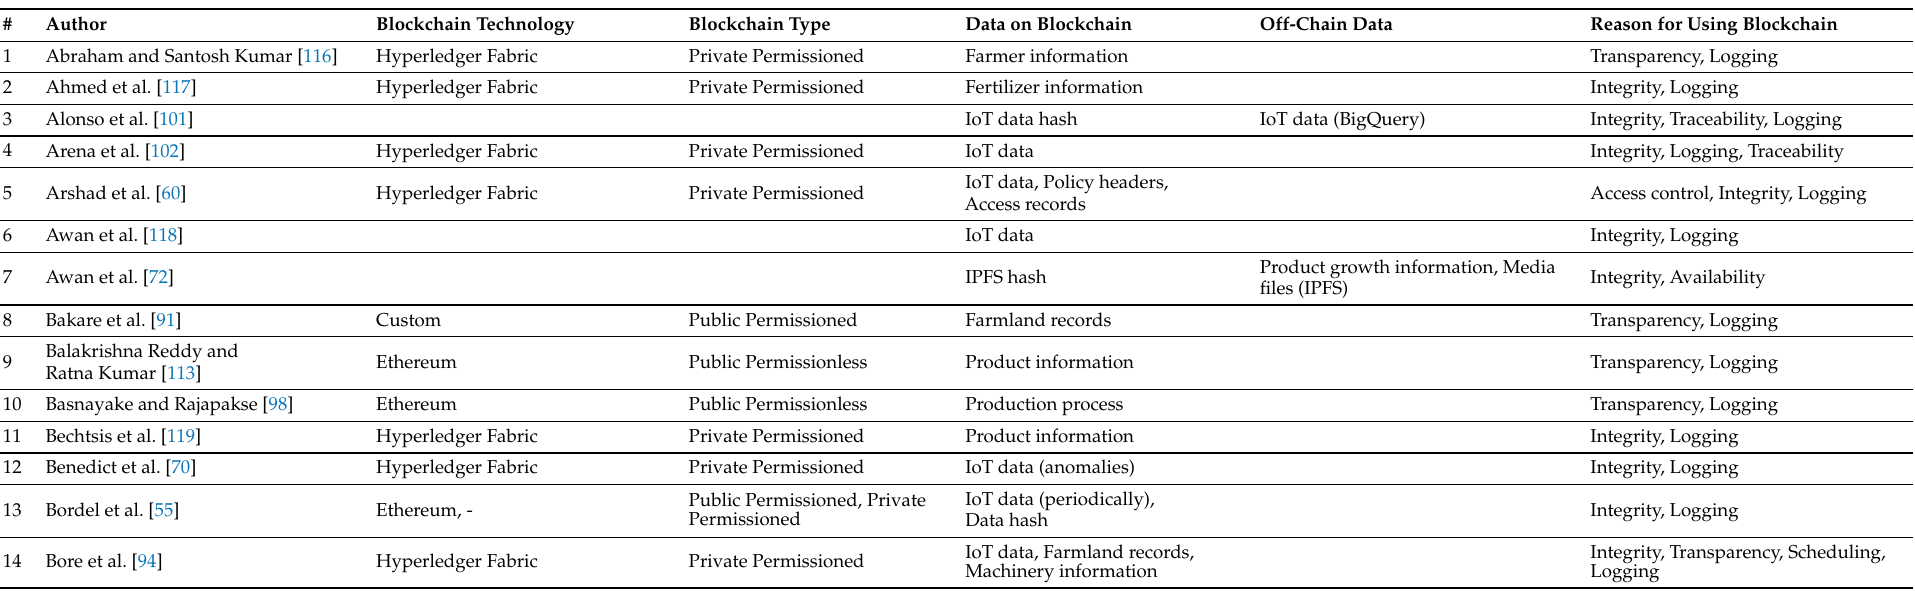
Table 2. Descriptive data on the particular blockchain application presented in each of the papers included in the scoping